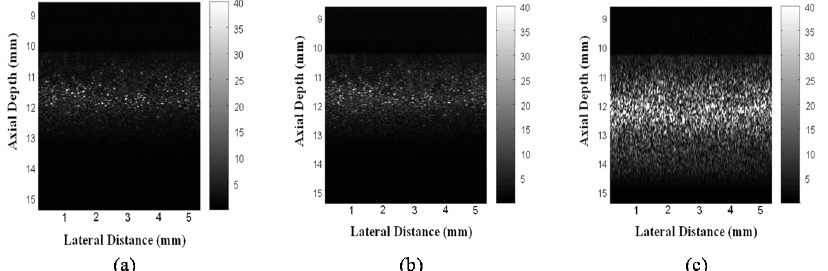
Figure 15. The images of the tissue ‐ mimicking ( a ) unipolar pulse, ( b ) bipolar pulse, or ( c ) chirp ‐ coded excitation.